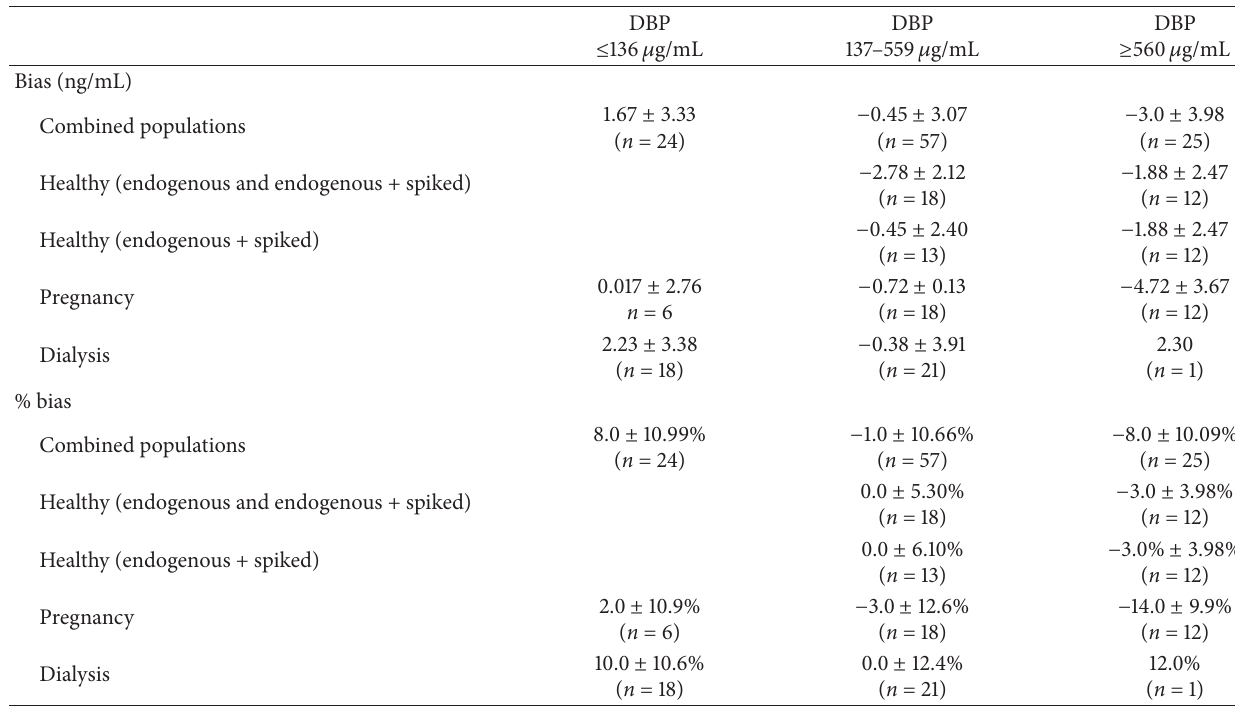
Table 4: Mean bias ( ± SD) compared to LC-MS/MS for the low, medium, and high range DBP groups for combined populations and each population separately: healthy and DBP-spiked, DBP-spiked, pregnant women, and dialysis